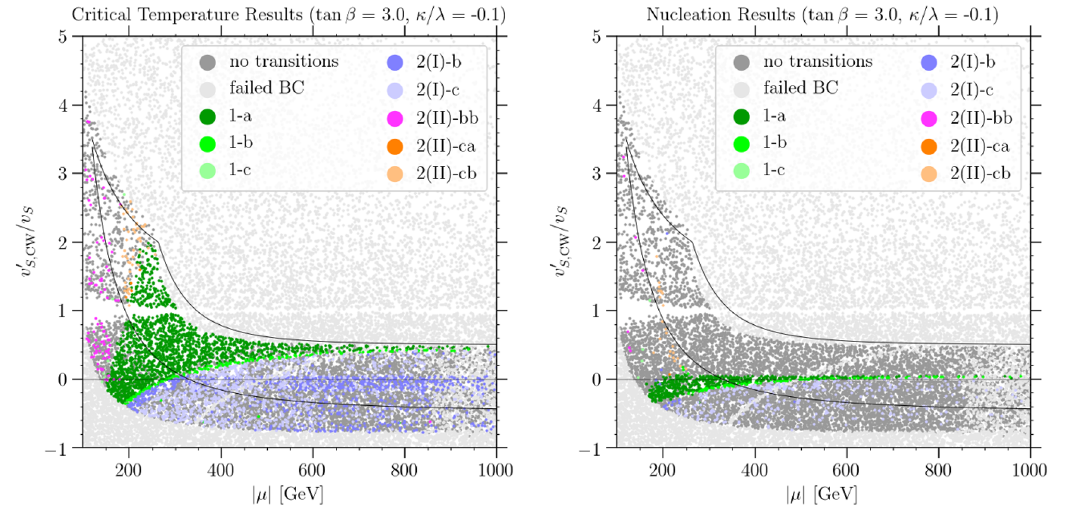
Figure 5 . Same as figure 4, but for tan β = 3 and κ/λ = − 0 . 1